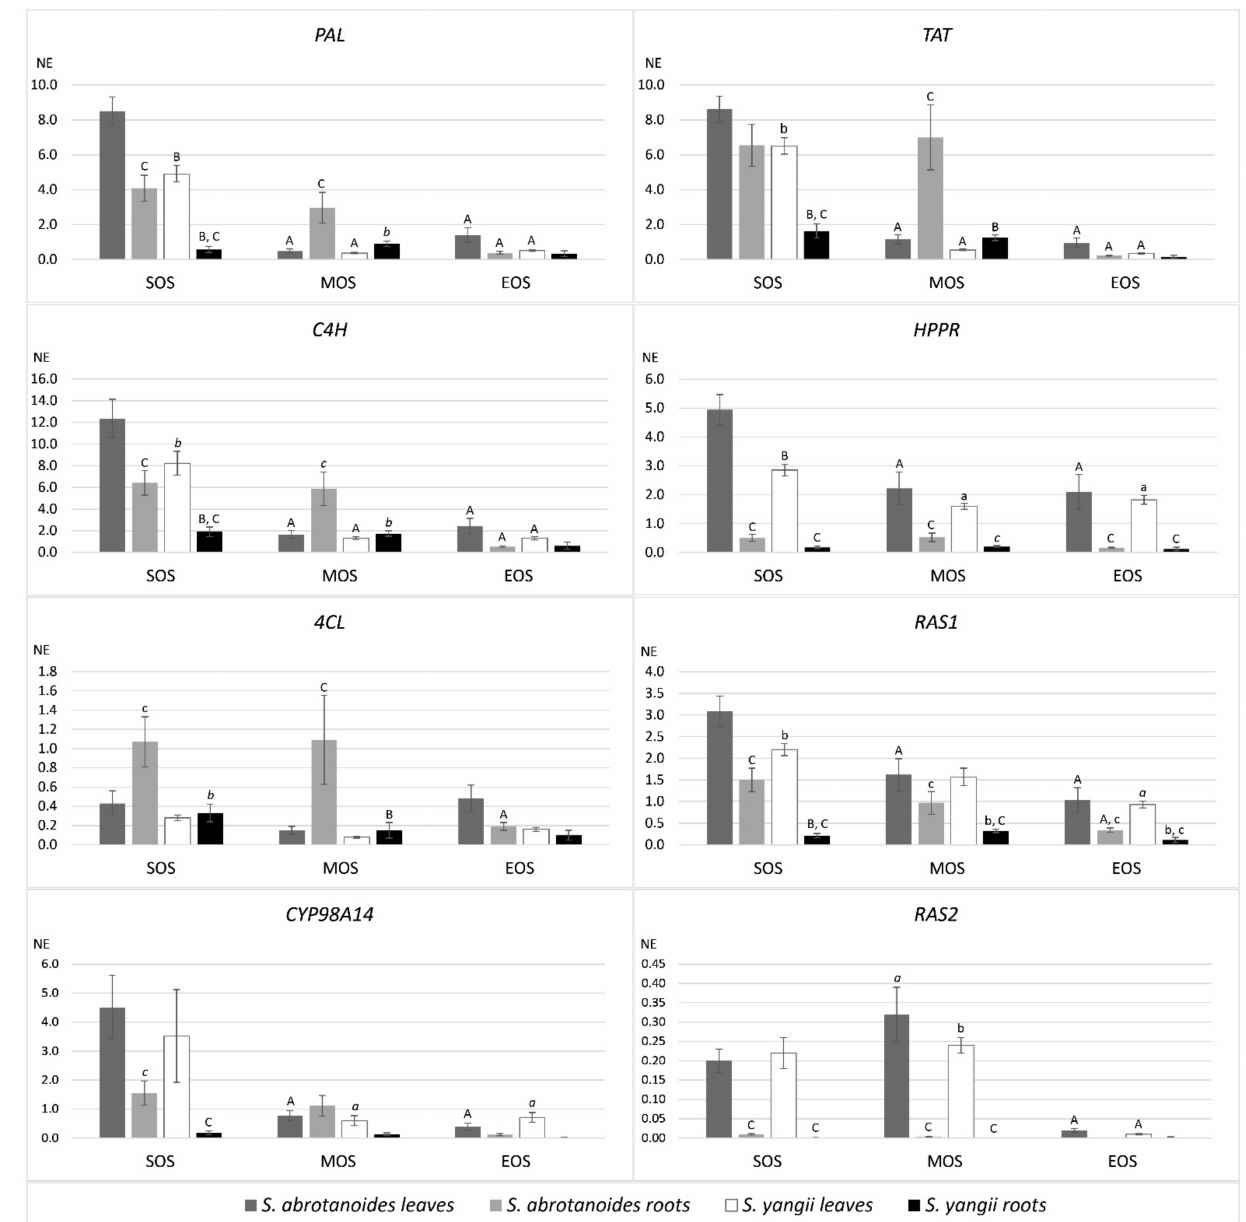
Figure 3. Expression levels of rosmarinic acid biosynthesis pathway genes in leaves and roots of S. abrotanoides and S.